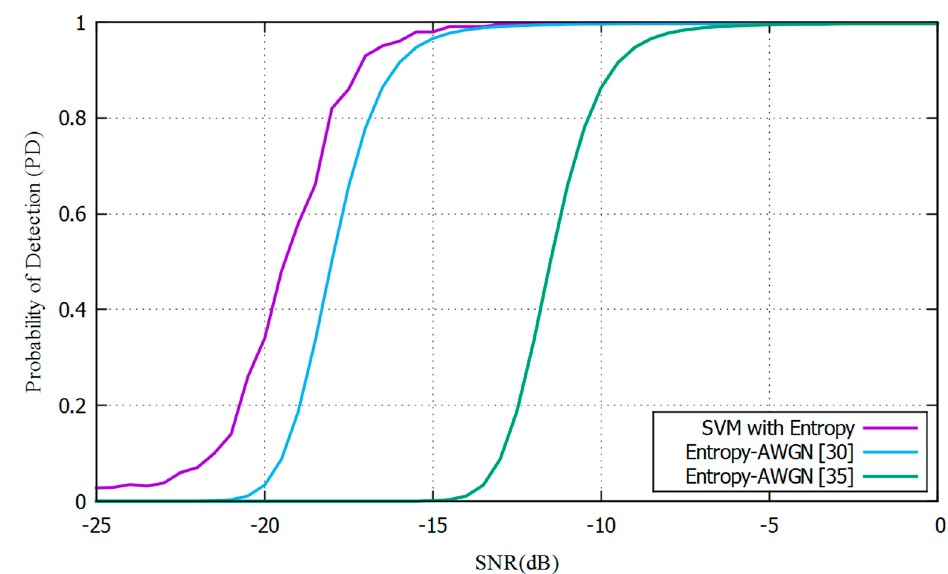
Figure 9. Probability of detection with SVM vs. entropy for GMSK.